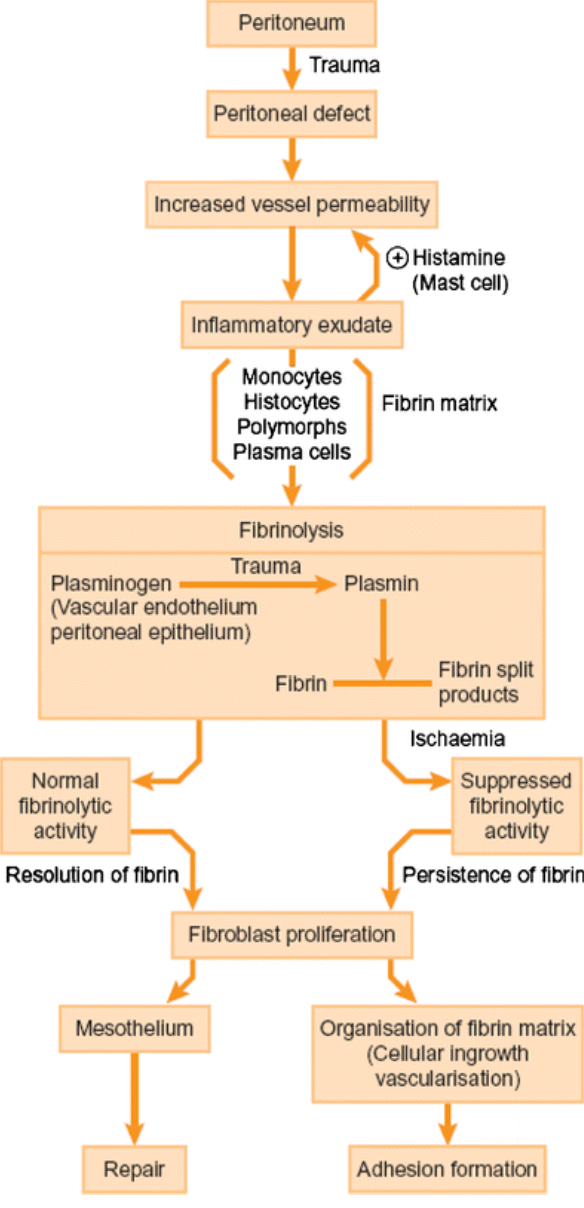
Figure 2. Pathogenesis of adhesion formation. Reproduced with permission from: De Wilde, R.L., Trew, G. & on behalf of the Expert Adhesions Working Party of the European Society of Gynaecological Endoscopy (ESGE) [5] .